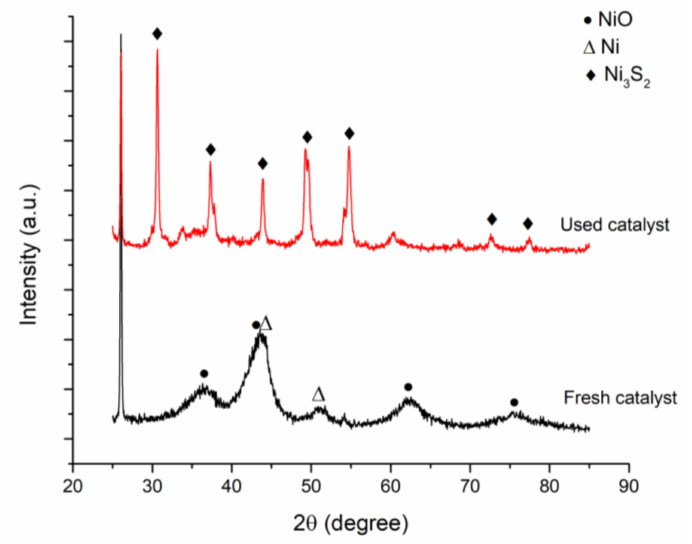
Figure 5. XRD of the catalyst before (black color) and after (red color) reaction at 8 bar, 350–500 ◦